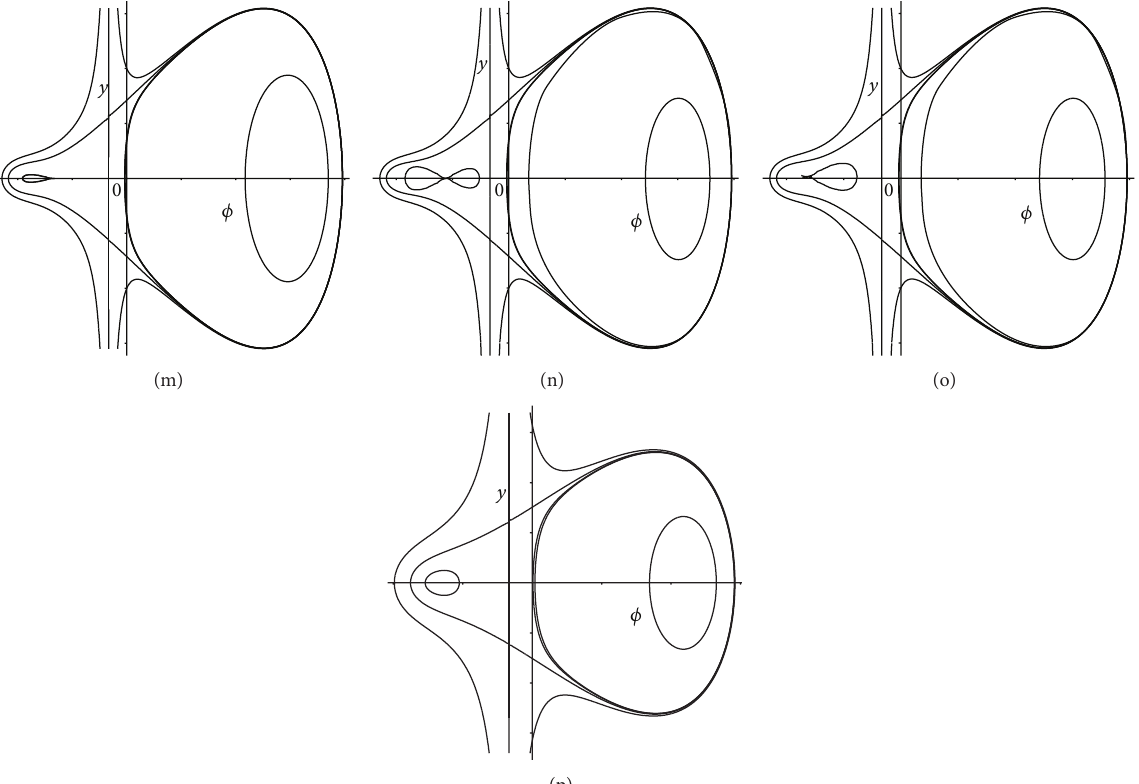
Figure 3: The bifurcation sets and phase portraits of system (13) when 𝑘 ̸= 0 . (a) (𝑐,𝑘) ∈ 𝐵 1 . (b) (𝑐,𝑘) ∈ 𝐵 2 . (c) (𝑐, 𝑘) ∈ 𝐵 3 . (d) (𝑐, 𝑘) ∈ 𝐵 4 . (e) (𝑐,𝑘) ∈ 𝐵 (𝑐, 𝑘) ∈ 𝐵 (𝑐, 𝑘) ∈ 𝐵 (𝑐,𝑘) ∈ 𝐵 (𝑐, 𝑘) ∈ 𝐵 (𝑐,𝑘) ∈ 𝐵 (𝑐, 𝑘) ∈ 𝐵 (𝑐, 𝑘) ∈ 𝐵 (𝑐, 𝑘) ∈ 𝐵 5 (f) 6 . (g) 7 . (h) 8 . (i) 9 . (j) 10 . (k) 11 . (l) 12 . (m) 13 . (n) (𝑐, 𝑘) ∈ 𝐵 (𝑐, 𝑘) ∈ 𝐵 (𝑐, 𝑘) ∈ 𝐵 14 . (o) 15 . (p) 16